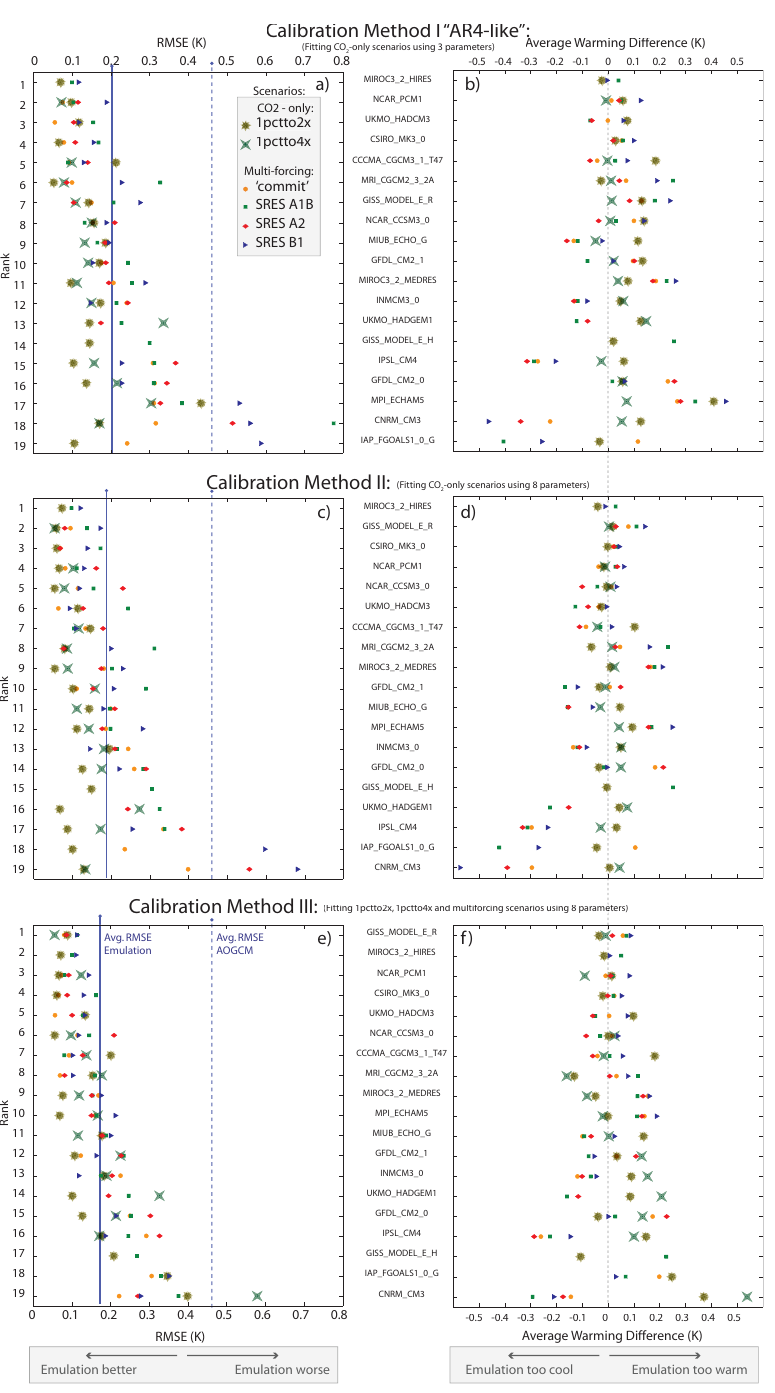
Fig. 5. The root mean square error (RMSE) and average warming differences between global-mean temperatures for individual AOGCMs and their emulations after calibrating MAGICC parameters with three different calibration procedures. Temperatures and ocean heat uptake for the 1pctto2 × and 1pctto4 × scenarios were fitted by calibrating three (calibration I; panel a, b) and eight (calibration II; panel c, d) MAGICC parameters, respectively (see Table 1). Calibration Method “III” (panel e,f) used in addition the multi-forcing runs SRES A1B, B1 and COMMIT when optimizing eight parameters (see Table 1). The emulations are ranked according to mean deviations (RMSE) between emulations and AOGCM data over the full length of all available scenarios. The AOGCM and MAGICC data were lowpass-filtered when calculating the RMSE values. For all emulations, “like-with-like” forcings were applied, i.e., the emulations were not subject to forcing adjustments. The mean RMSE for all emulations is given (“Avg. RMSE Emulations”) and compared to the average inter-model RMSE (“Avg. RMSE AOGCM”). See